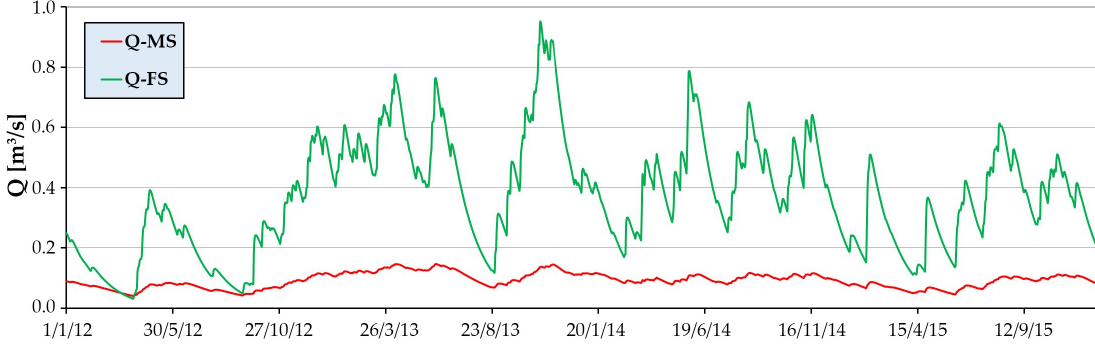
Figure 10. Flow distribution between the diffuse (MS) and the fracture (FS) flow components through the analysed karst